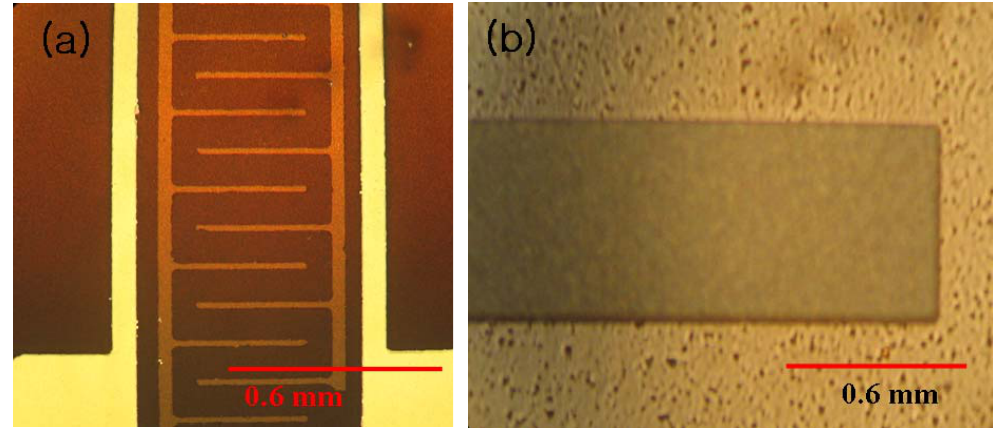
Figure 12. Plane Views of cantilevers: (a) d 33 type and (b)d 31 type.